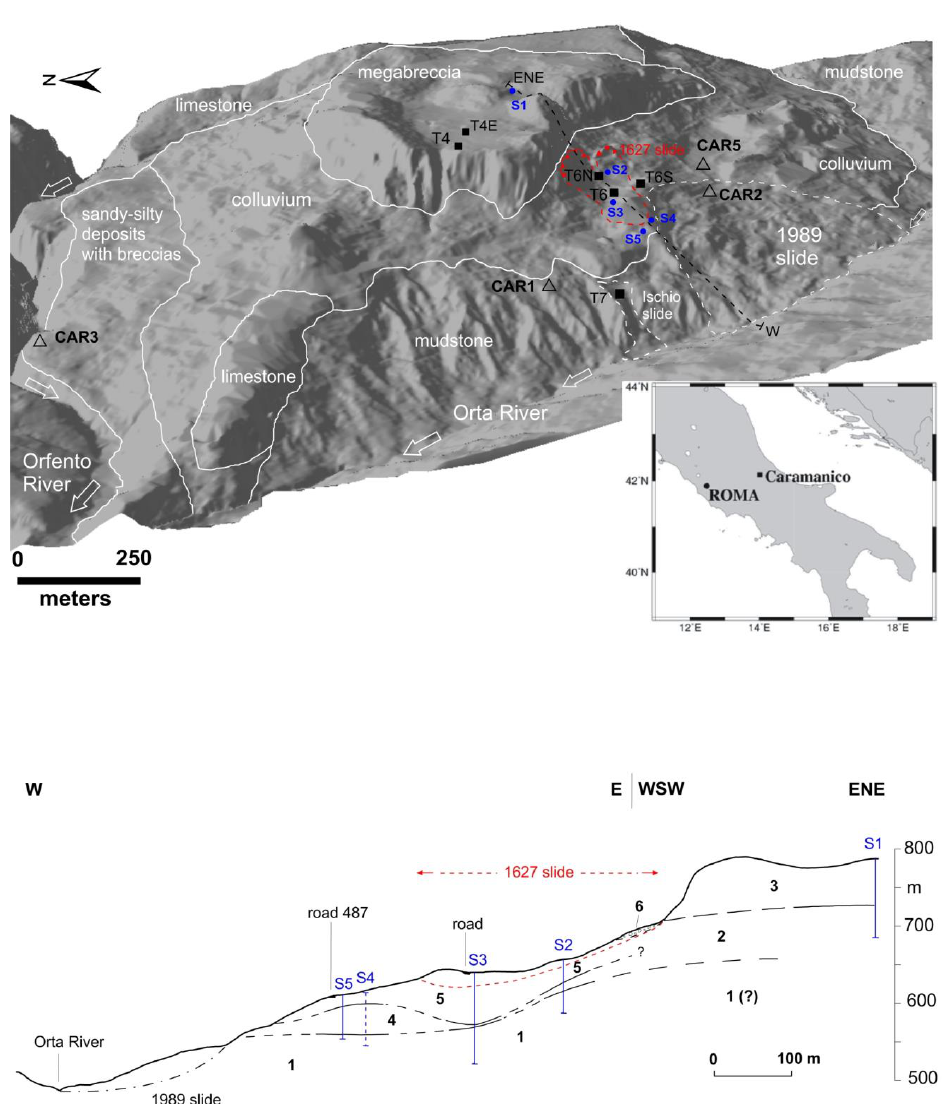
Fig. 1. Upper: geographic location of the Caramanico test area (inset) and DEM showing lithology and measurement sites (modified after Del Gaudio and Wasowski, 2011). White continuous and dashed lines mark, respectively, lithological contacts and boundaries of investigated landslides; two possible source areas for the 1627 landslide (in red) are indicated. CAR1-5 marks the location of the accelerometer stations (reference station CAR4, located 2.5km SE of Caramanico, is not shown); T4, T4E, T6, T6N, T6S and T7 indicate the additional sites of HVNR measurements discussed in the paper; S1-5 shows borehole positions; dashed black line indicates location of geological profile. Lower: simplified geological profile of the slope affected by Colle Alto hillslope (modified after Wasowski and Del Gaudio, 2000). Sym- bols: S1–5 = boreholes; 1 = mudstone substratum; 2 = clay-rich silty sandy deposits found in borehole S1, including variable admixtures of carbonate debris; clasts are subrounded in the lower third part of the borehole; 3 = carbonate megabreccia (caprock); 4 = remoulded clay- rich materials containing variable amounts of angular clasts, of inferred mass movement origin; 5 = variably cemented carbonate breccias; 6 = recent carbonate detritus of rockfall origin. Dashed red line indicates inferred subsurface limit of the 1627